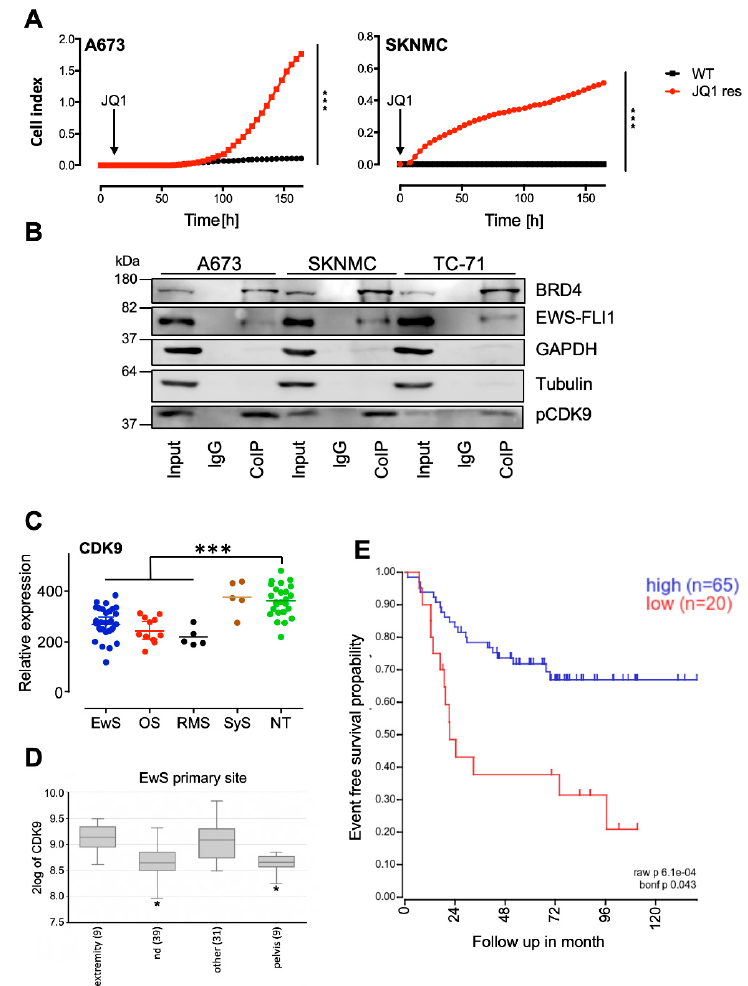
Figure 1. Development of JQ1 resistant Ewing sarcoma (EwS) and interaction with p-CDK9. ( A ) EwS cell lines A673 and SKNMC were treated for 5–6 weeks with 2 µ M JQ1 (JQ1 res) and analyzed subsequently by xCELLigence assay. Wild type (WT) A673 and SKNMC cell lines were used as controls. All cells were treated with 2 µ M JQ1 during measurement. Cellular impedance was measured every 4 h (relative cell index). Data are mean ± SEM (hexaplicates / group); t -test, *** p -value < 0.0005. ( B ) Interaction analysis by Co-IP of BRD4, EWS-FLI1, and p-CDK9. Co-IP for A673, SKNMC, and TC-71 cell lines using anti-BRD4 antibodies. After Co-IP, proteins were analyzed by Western blotting for p-CDK9, BRD4, and EWS-FLI1. GAPDH and Tubulin served as a loading control. ( C ) Gene expression profiles of the CDK9 gene on 27 EwS, 11 osteosarcomas (OS), 5 rhabdomyosarcomas (RMS), 5 synovial sarcomas (SyS), and 25 samples of di ff erent normal tissue (NT). Patient RNA were hybridized onto Human Gene ST1.0 arrays (A ff ymetrix; GSE45544, GSE73166) and compared to a published microarray study of normal tissue (GSE45544). *** p -value < 0.0005. ( D ) Di ff erential expression levels of CDK9 in primary EwS at di ff erent tumor sites by box plot presentation using the GSE63157 study set and the amc onco-genomics software tool (https: // hgserver1.amc.nl / cgi-bin / r2 / main.cgi.). The number of samples in each cohort is given in brackets. * p -value < 0.05 ( E ) CDK9 expression correlates with event-free survival: Kaplan–Meier estimates for event-free survival probability for CDK9 expression ( n = 85, p = 0.043), GSE63157 study